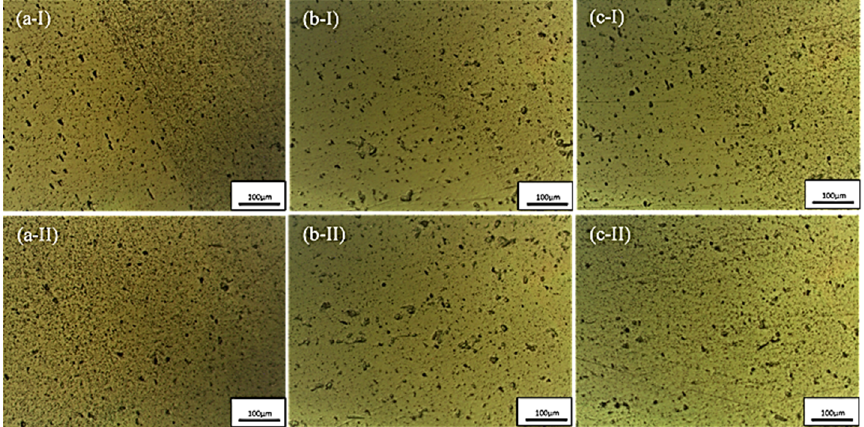
Figure 24. Microstructure of FSPed surface using CTH tool at 1250 rpm for feed rates of, ( a ) 20 mm/min, ( b ) 25 mm/min, and ( c ) 30 mm/min of different regions, whereby (a-I–c-I) is HAZ-SZ boundary and (a-II–c-II) is the SZ.